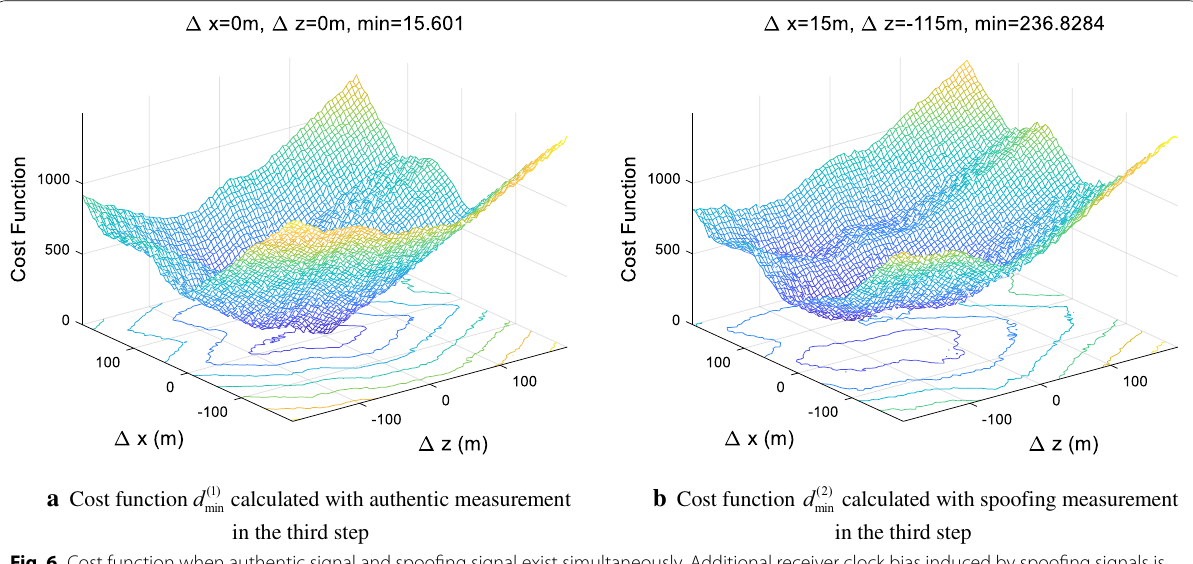
Fig. 6 Cost function when authentic signal and spoofing signal exist simultaneously. Additional receiver clock bias induced by spoofing signals is